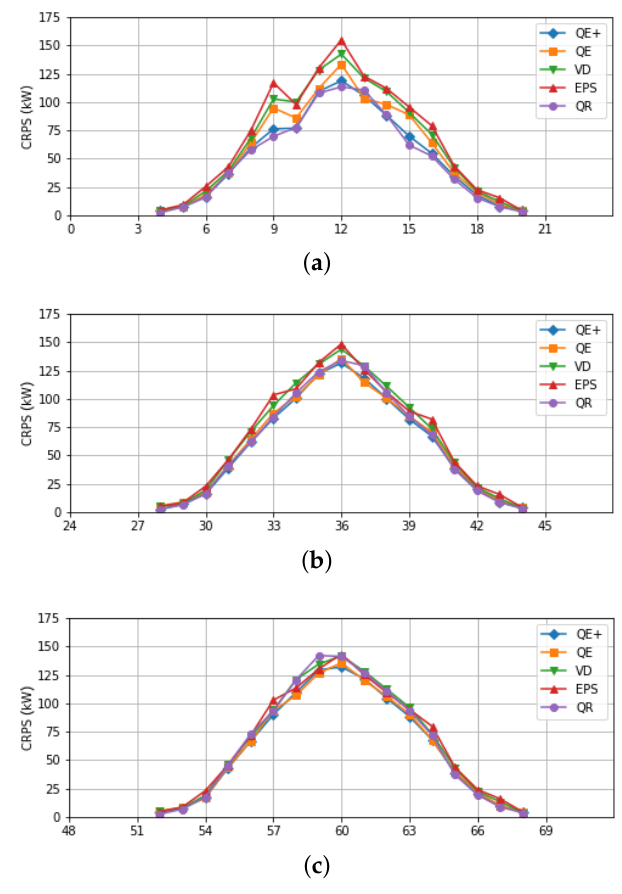
Figure 4. CRPS results as the lead time forecast varies for the probabilistic forecast methods examined: ( a ) CRPS values for times of forecast in 0–24-h time range; ( b ) same as before for 24–48-h; ( c ) same for